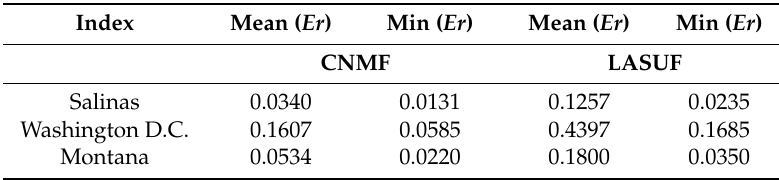
Table 6. Comparison of endmembers’